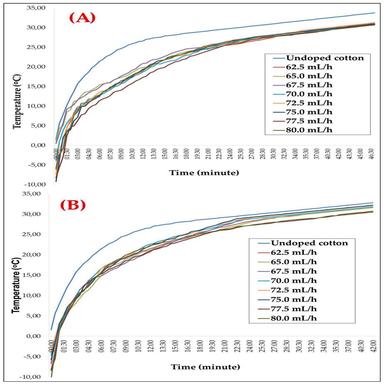
Thermal History (T-History) Results of nanocapsule-doped composite yarn with different nanocapsule concentrations A: 3 % capsule concentration, and B: 9 % capsule concentration.